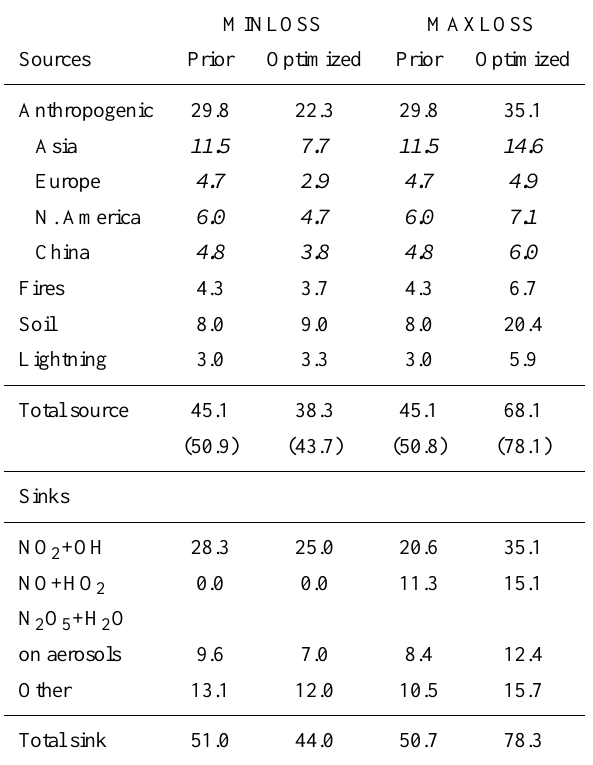
Table 2. Annual NO x emissions and tropospheric sinks (TgN) in the MINLOSS and MAXLOSS scenarios. Global anthropogenic in- cludes shipping and aircraft. The total source given between brack- ets includes the production due to HNO 3 photolysis and reaction with OH. Regional anthropogenic emissions are